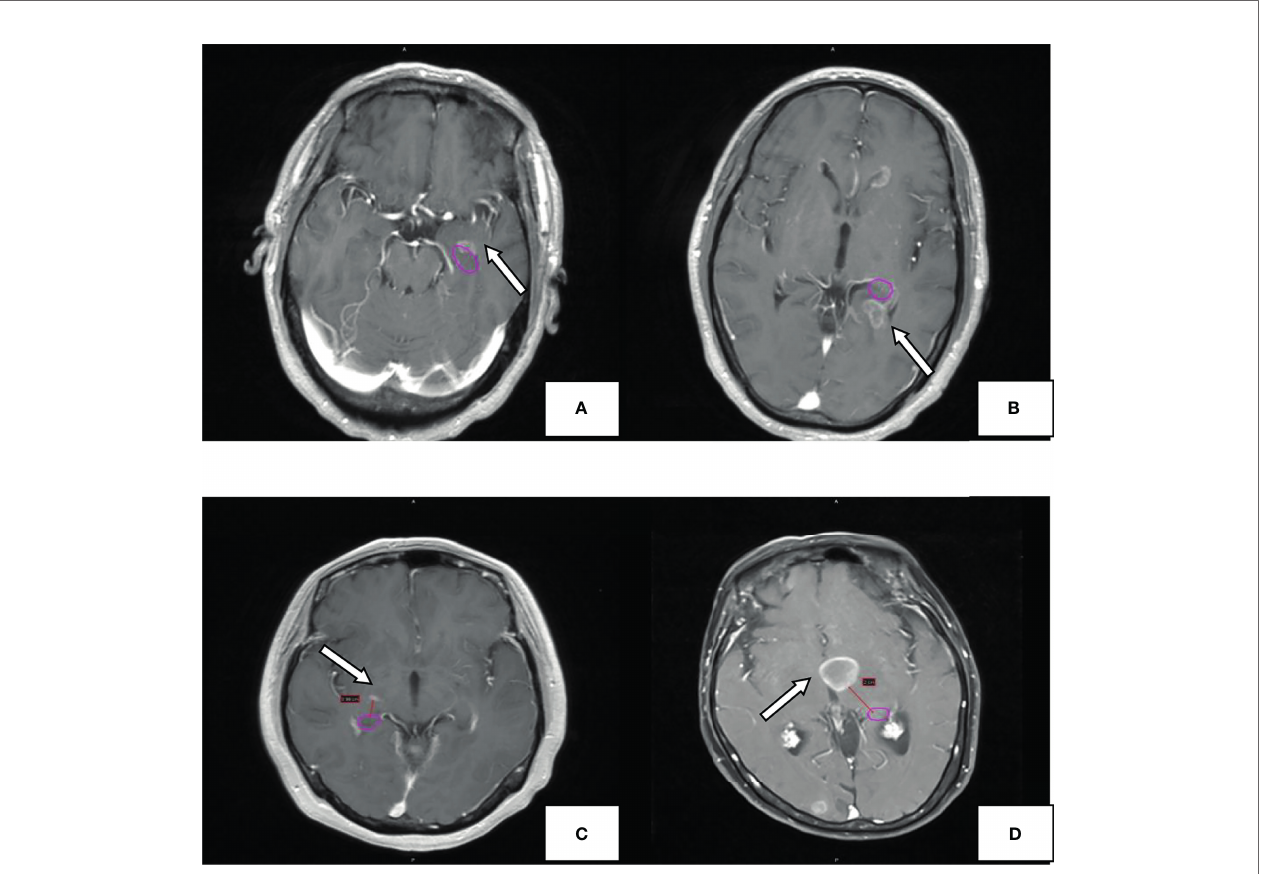
FIGURE 1 | Example for hippocampal metastasis. The pink circle represents the hippocampal contour; the arrow points to the metastasis. Brain metastases invade the hippocampus (A) , hippocampus+5mm area (B) , hippocampus+10mm area (C) . hippocampus +20mm area (D)